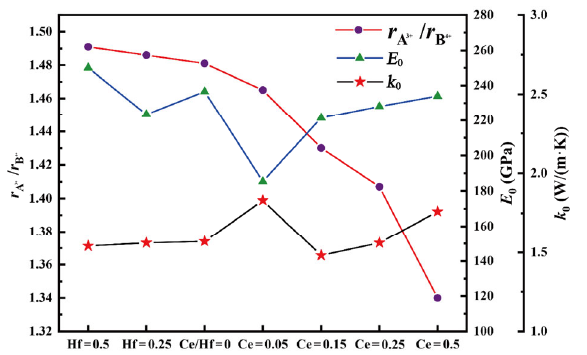
Fig. 6 Effect of B-site doping on r A 3+ / r B 4+ , E 0 , and k 0 of A 2 B 2 O 7 high-entropy ceramics.